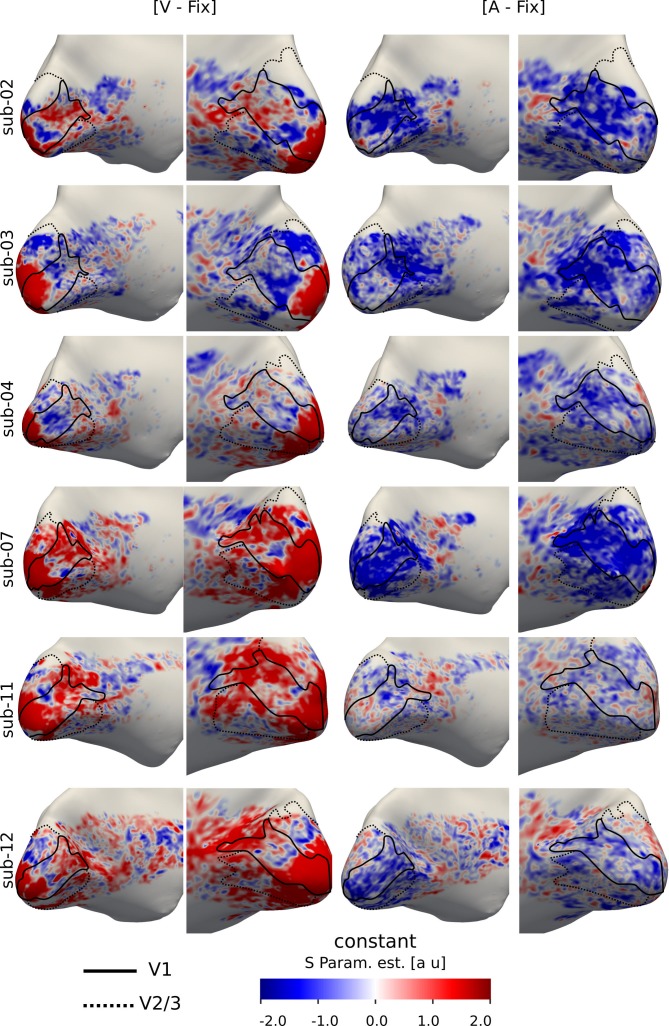
Auditory and visual responses in visual areas.Surface projection for individual subjects: Within subject ‘constant’ shape parameter estimates of the laminar BOLD response profile for visual (column i and ii) and auditory (column iii and iv) stimuli are projected on each subject’s inflated surface to show visual regions of the left (column i and iii) and right (column ii and iv) hemisphere. V1 and V2/3 are delineated by black solid and dashed lines respectively. For visualization purposes only, surface projections were smoothed (FWHM = 1.5 mm). Grey areas denote vertices with no available data.